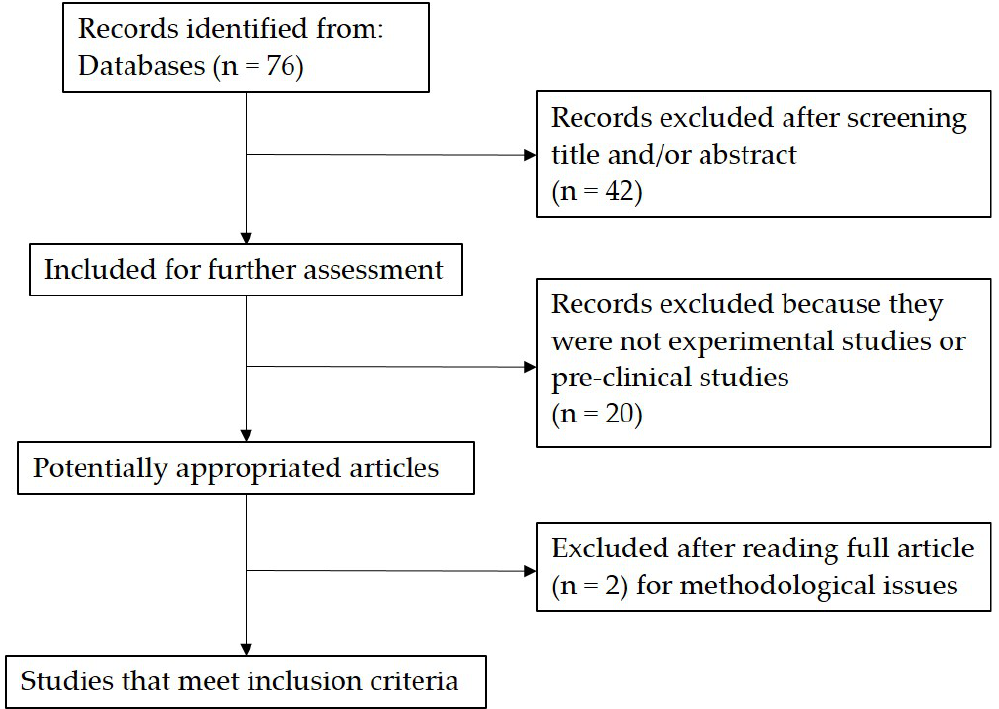
Figure 1. Summary of studies identification and selection.